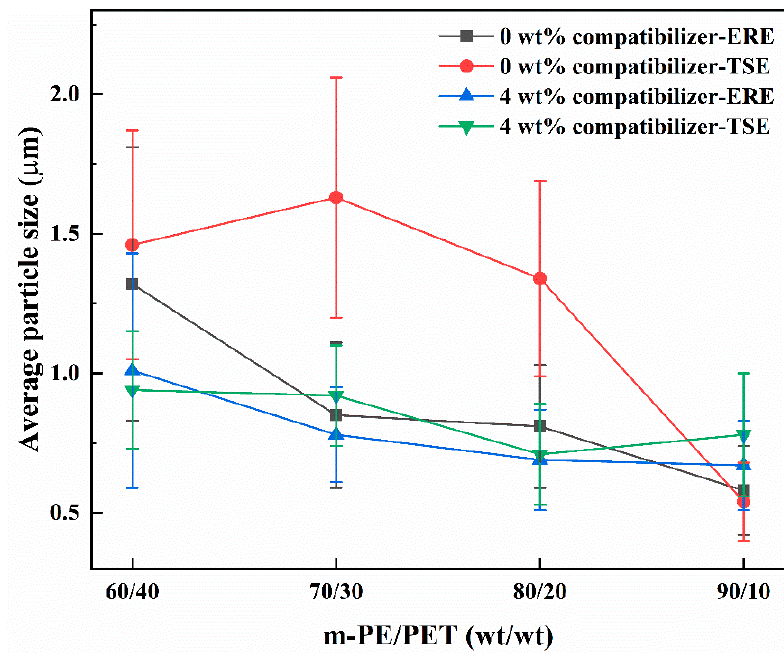
Figure 6. Average particle size of m-PE / PET blends (0 wt% and 4.0 wt% compatibilizer loaded) processed using ERE and TSE, respectively.